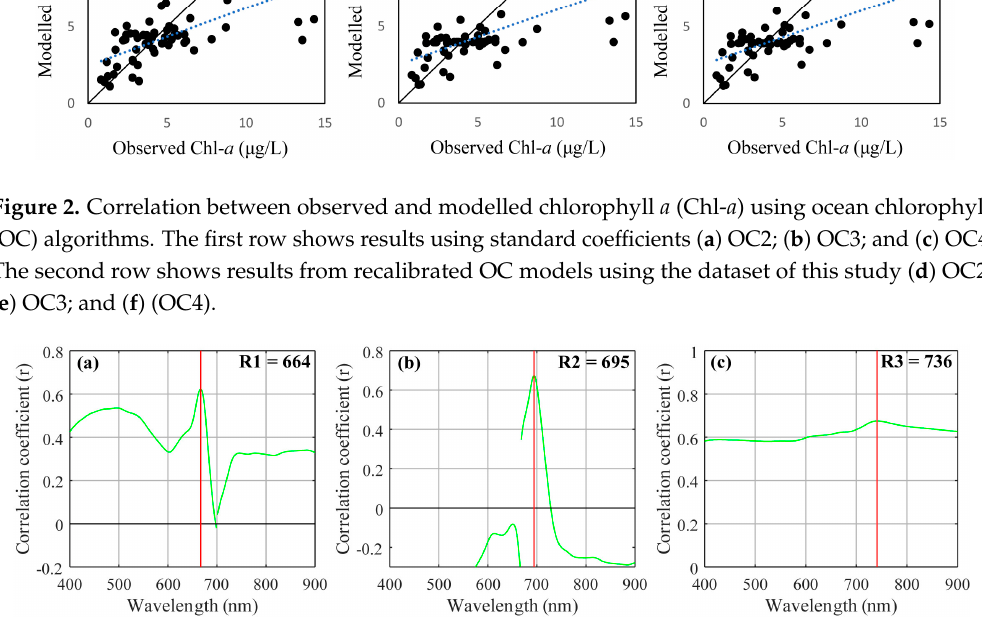
Figure 3. Selected wavebands for the three-band model algorithm using the tuning method ( a ) optimal band λ 1; ( b ) optimal band λ 2; and ( c ) optimal band λ 3.